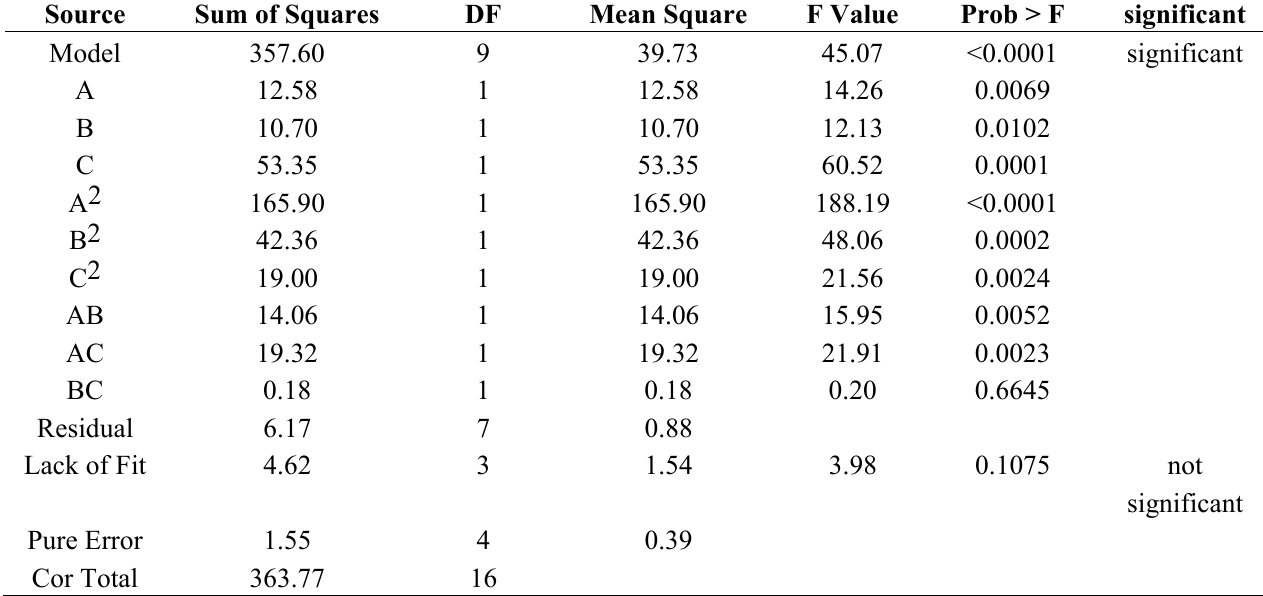
Table 2. ANOVA for Response Surface Quadratic Model: Analysis of variance table [Partial sum of